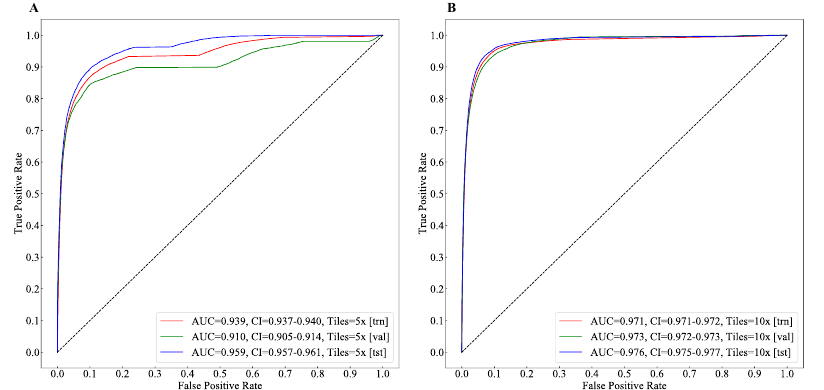
Figure 6. The receiver operator characteristic (ROC) curve and area under the curve(AUC) of tumor classification using 5 × and 10 × tiles of the whole slide images (WSIs). ( A ) The curves of training, validating, and testing set using 5 × tiles. ( B ) The curves of training, validating, and testing set using 10 × tiles.